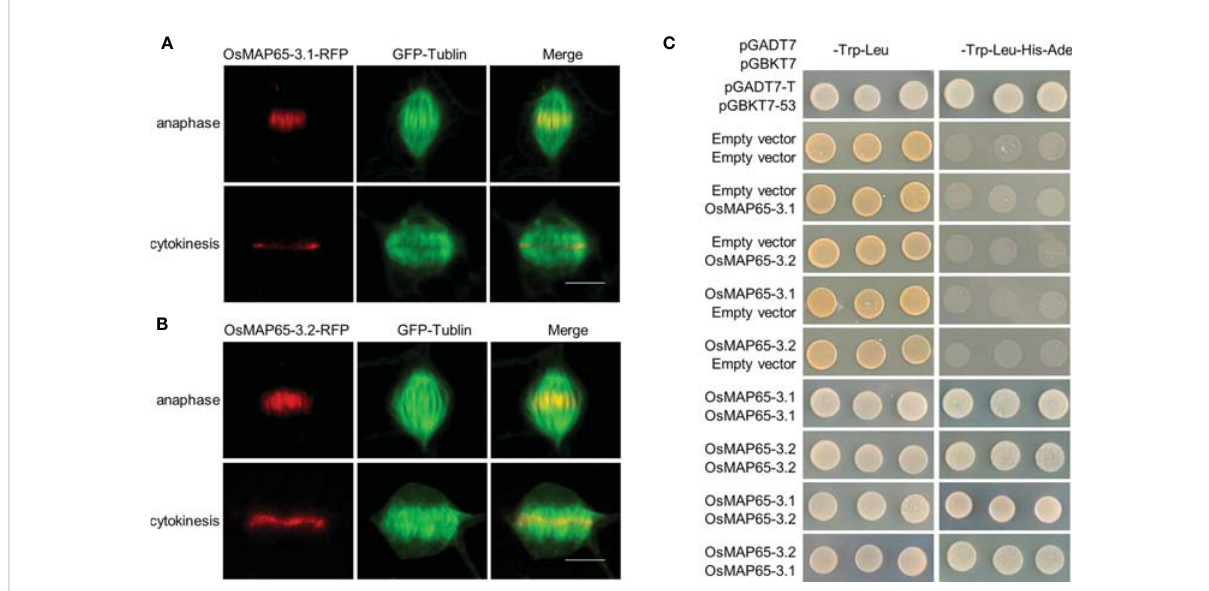
(C) Yeast-Two-Hybrid Assay of dimerization of OsMAP65-3.1 and OsMAP65-3.2. The left panel indicate the co-transfomed yeast cells spotted onto nonselective medium lacking Leu and Trp, and the right panel indicate those on selective medium lacking Leu, Trp, His, and